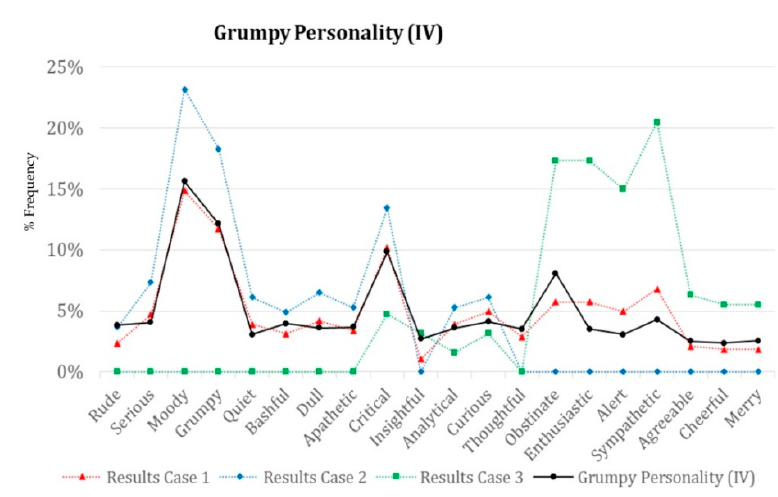
Figure 16. Comparison of cases for a Gloomy Personality.